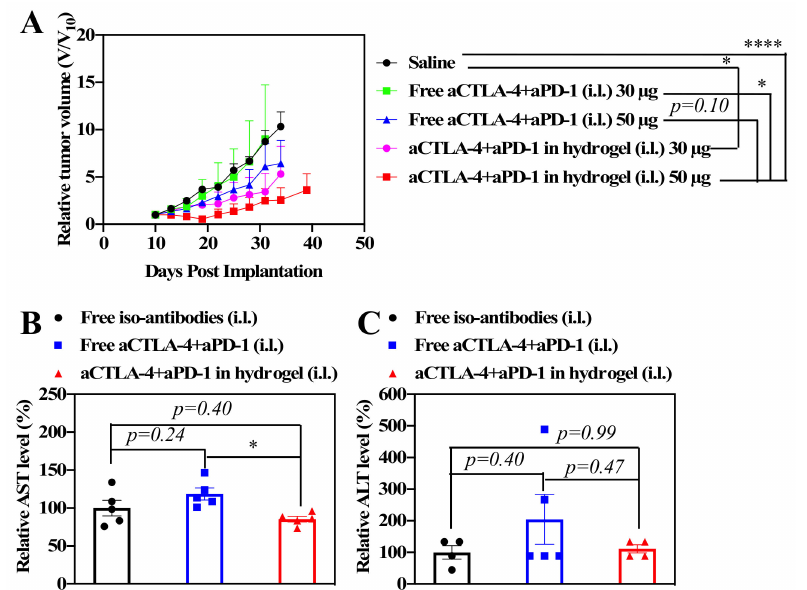
Figure 3. Antitumor effects of aCTLA-4+aPD-1 containing F127/PEG hydrogels in vivo . ( A ) Tumor size after one administration of saline, free aCTLA-4+aPD-1 (30 or 50 µ g total dose of each monoclonal antibody (mAb) clone), or aCTLA-4+aPD-1 (30 or 50 µ g total dose of each mAb clone) containing F127/PEG hydrogels injected intradermally (i.d.) into the tissue ipsilateral (i.l.) to the tumor on day 10. ( B ) Aspartate aminotransferase (AST) and ( C ) alanine aminotransferase (ALT) in blood 2 d after treatment of 50 µ g aCTLA-4+aPD-1. ( A ) was analyzed with two-way ANOVA. ( B ) and ( C ) were analyzed with one-way ANOVA. **** p < 0.0001 and * p <